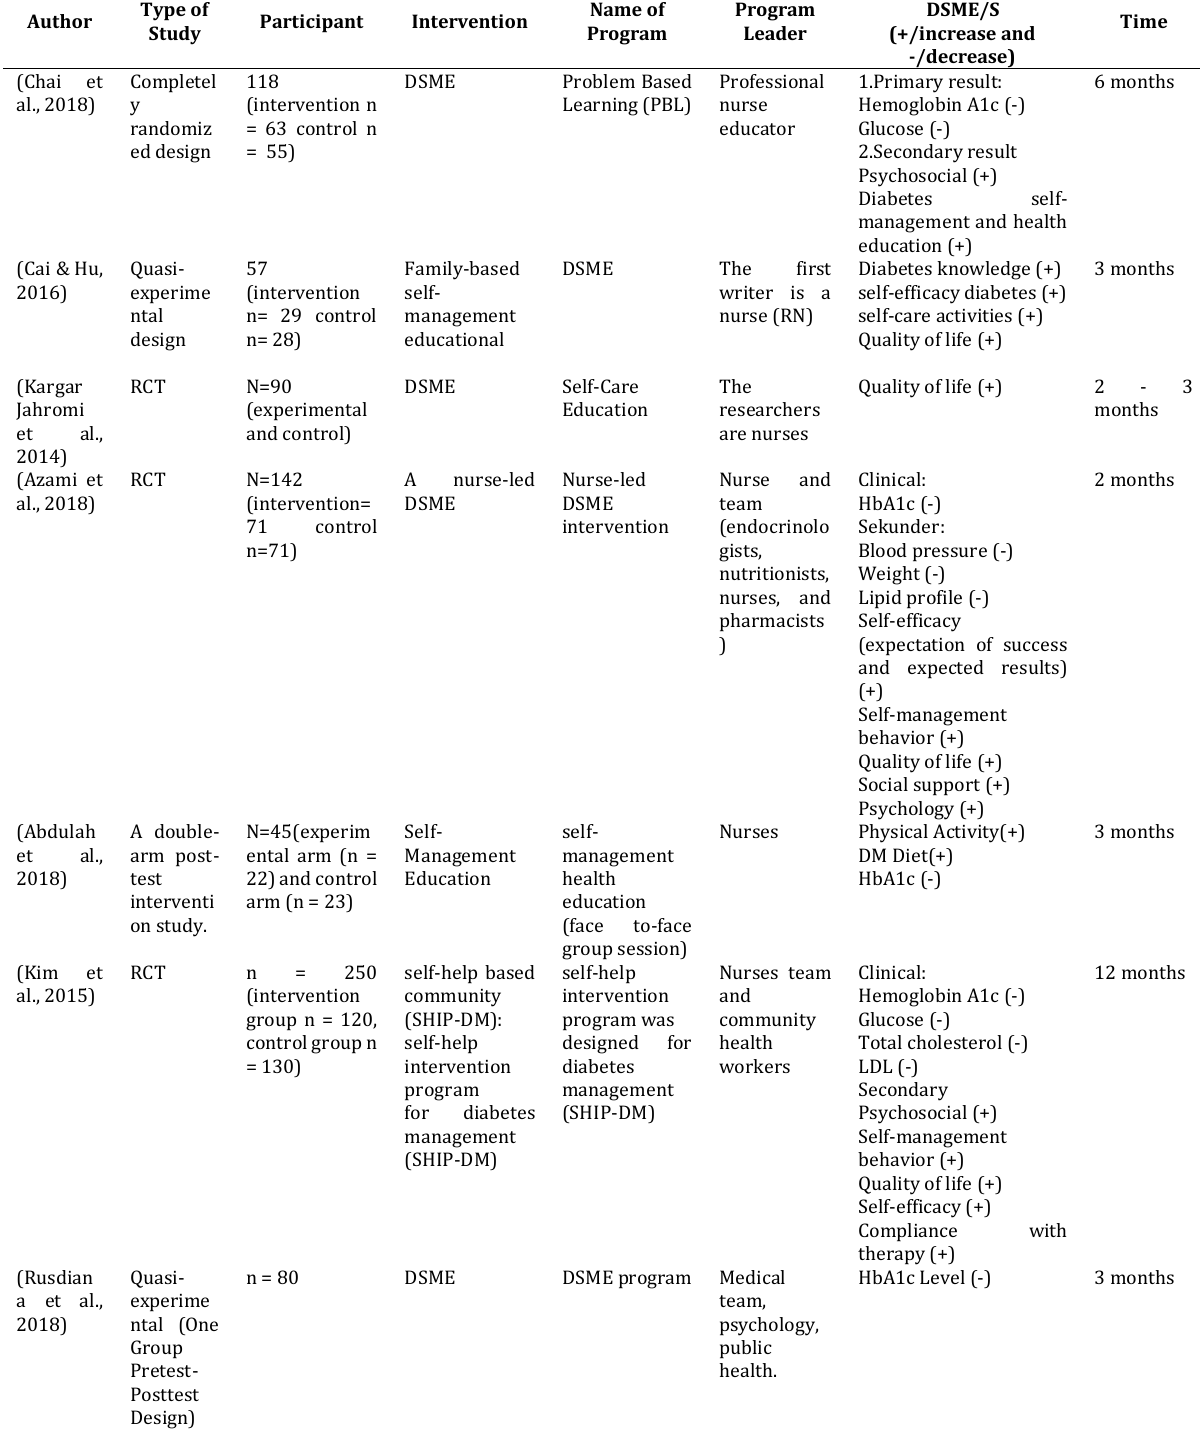
Table 2. Experimental Studies and RCTs of DSME/S type 2 diabetes mellitus as the basis of the systematic review